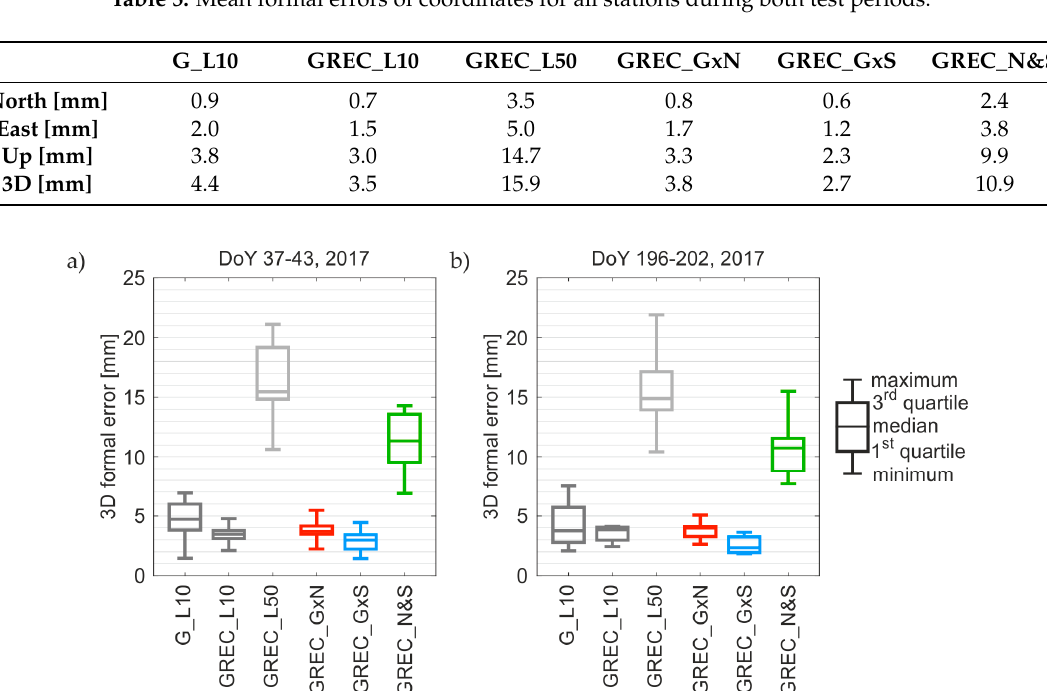
Figure 7. Three-dimensional (3D) coordinate repeatability obtained in static PPP using different weighting schemes.